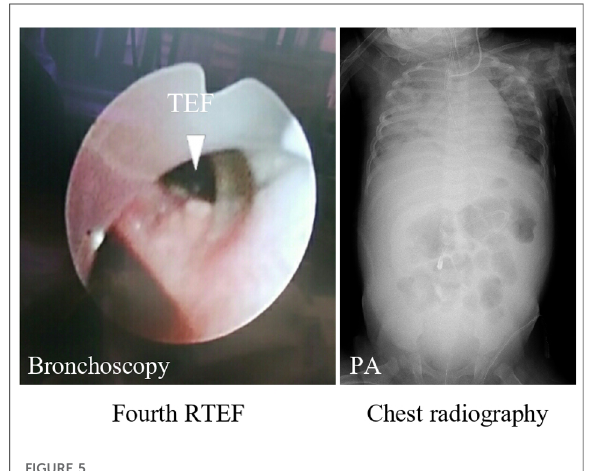
FIGURE 5 Bronchoscopy shows the fourth RTEF with a big hole